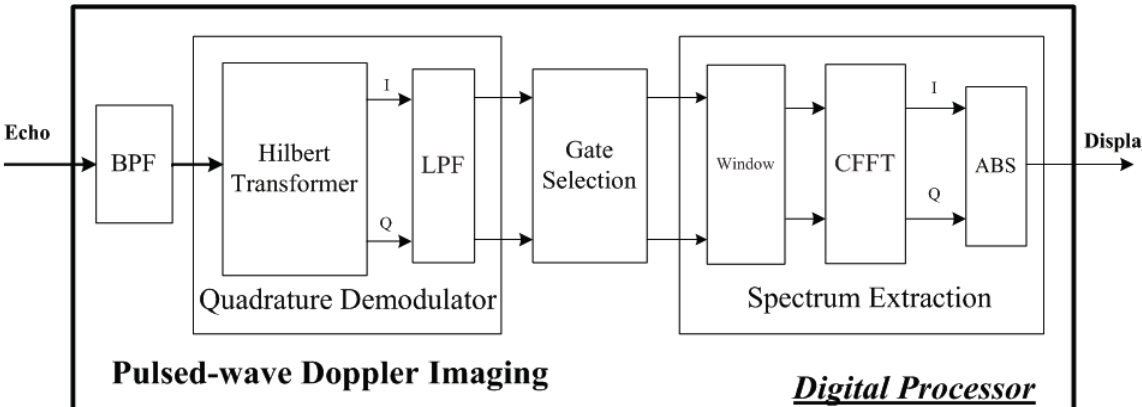
Figure 2. The digital algorithms implemented for real-time PW Doppler